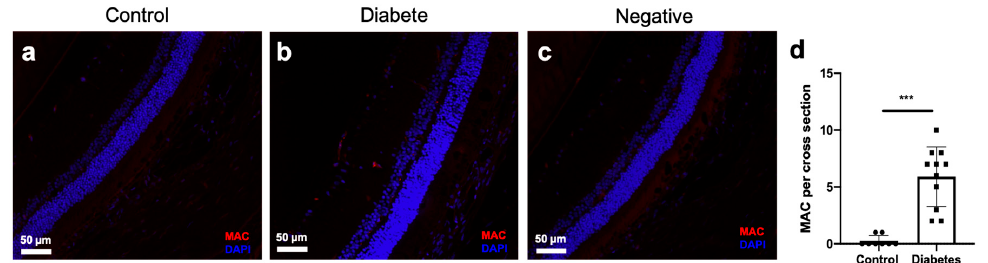
Figure 6. Membrane attack complex (MAC) deposition in the retina of rats with seven-weeks duration of STZ-induced diabetes. Retinal sections from a control rat ( a ) showed less MAC immunostaining (red fluorescence) than in a diabetic rat ( b ). ( c ) MAC negative staining of the diabetic rat retina section. Deposition and cellular nuclei (DAPI) staining in blue fluorescence. ( d ) Counts of the number of MAC deposits per retinal cross-section, *** p < 0.001, n = 7 – 11.